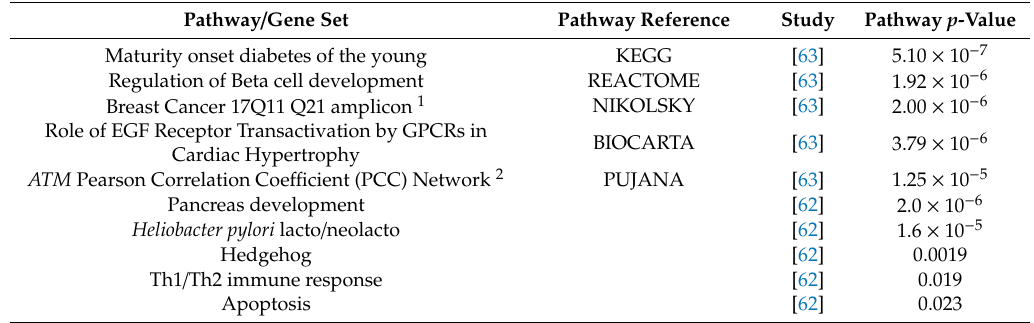
Table 2. Gene sets / pathways identified for risk of developing PDAC from pathway analysis studies [62,63].